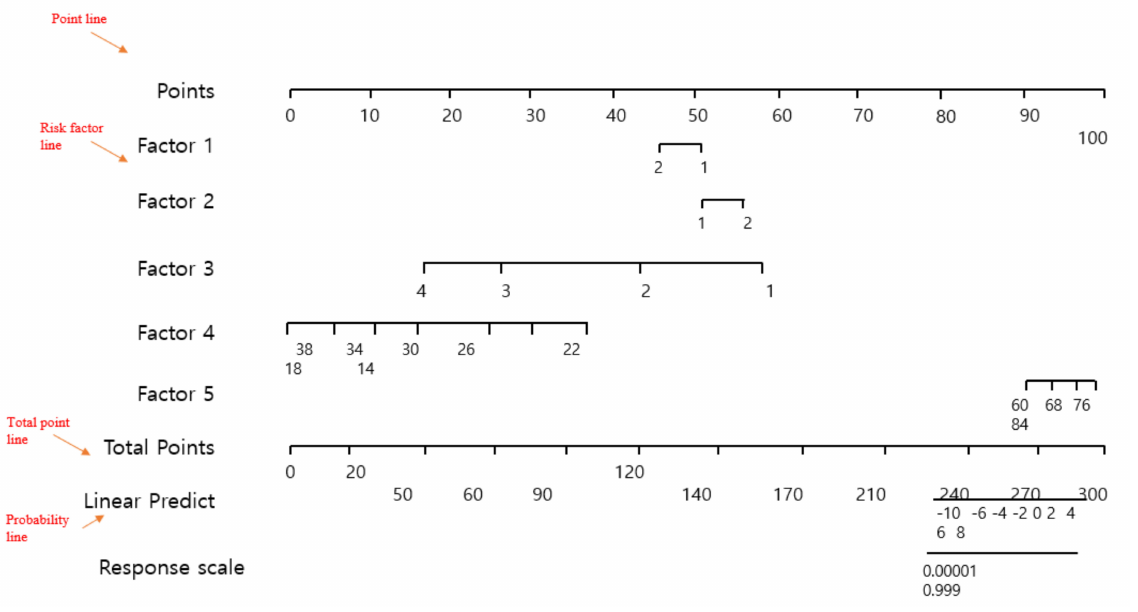
Figure 2. The concept of a logistic regression